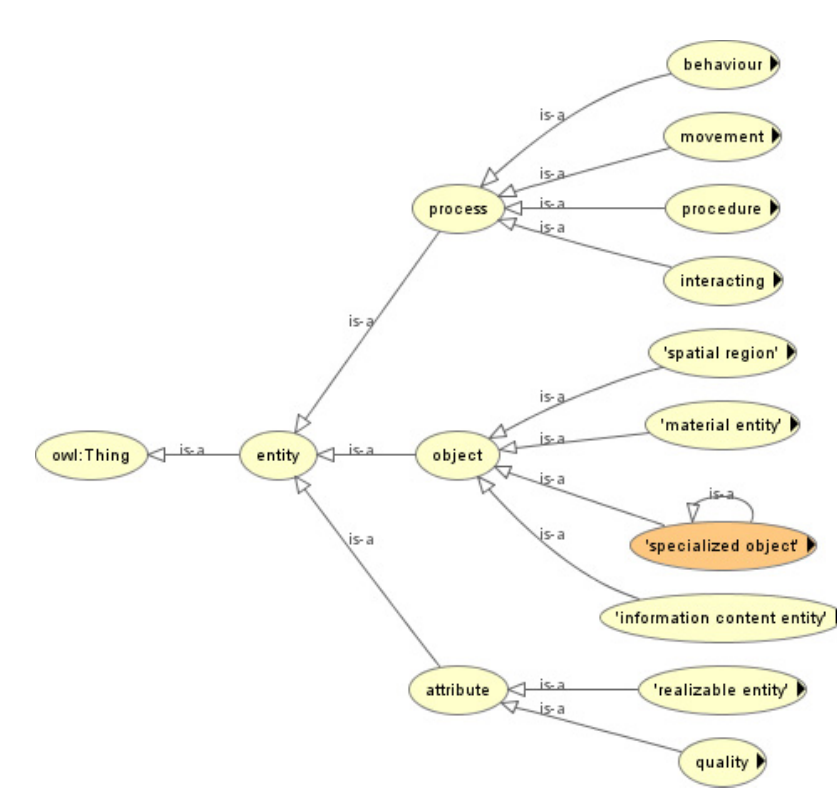
Fig. 8. General abstract classes of the